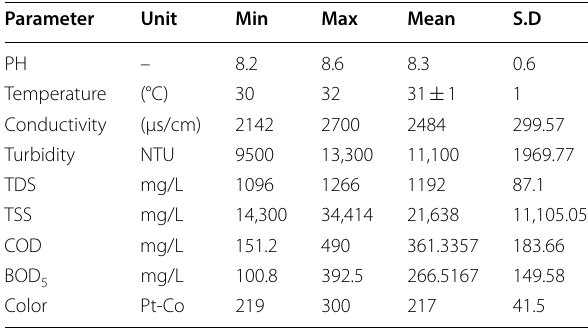
Table 1 Characteristics of the raw wastewater tile